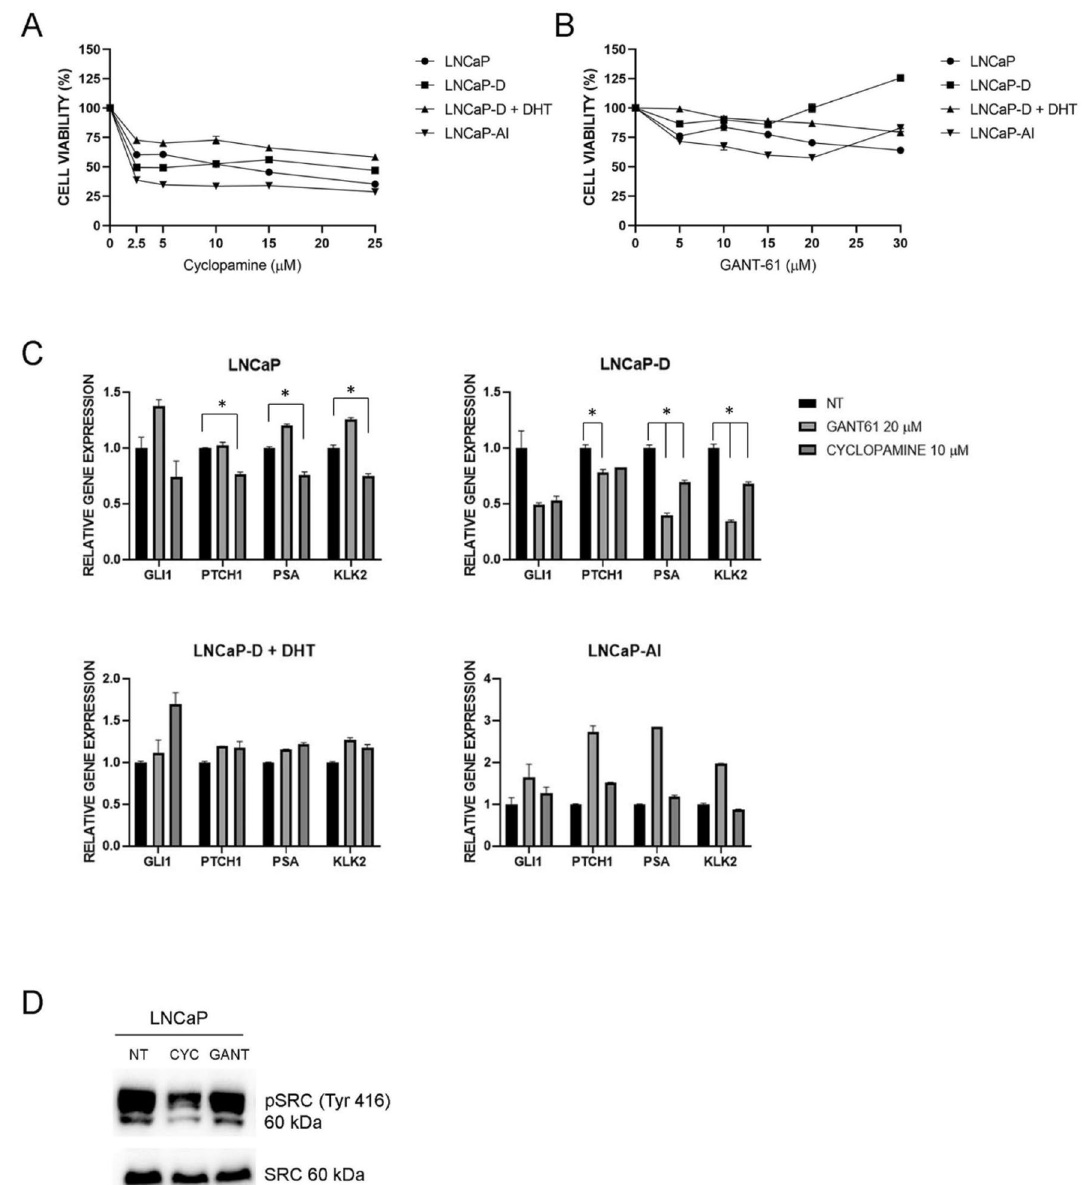
Figure 2. Effects of HH-GLI signaling inhibitors on cell proliferation and pathway activity. ( A ) Effects of cyclopamine on proliferation of LNCaP, LNCaP-D, LNCaP-D + DHT and LNCaP-AI cells. Cyclopamine elicits an inhibitory effect on cell proliferation. ( B ) Effects of GANT-61 on proliferation of LNCaP, LNCaP-D, LNCaP-D + DHT and LNCaP-AI cells. GANT-61 elicits only a weak effect on cell proliferation. ( C ) Effects of cyclopamine and GANT-61 on HH-GLI and AR pathway activity. Cyclopamine partly downregulates HH-GLI signaling and downregulates AR signaling in LNCaP cells. Both inhibitors show an inhibitory effect on HH-GLI and AR pathway activity after short-term androgen deprivation (LNCaP-D). ( D ) In LNCaP cells, cyclopamine inhibits SRC activation, measured by its phosphorylation at Tyr416, while the levels of total SRC remain constant. Significant downregulation (P < 0.05) is indicated with